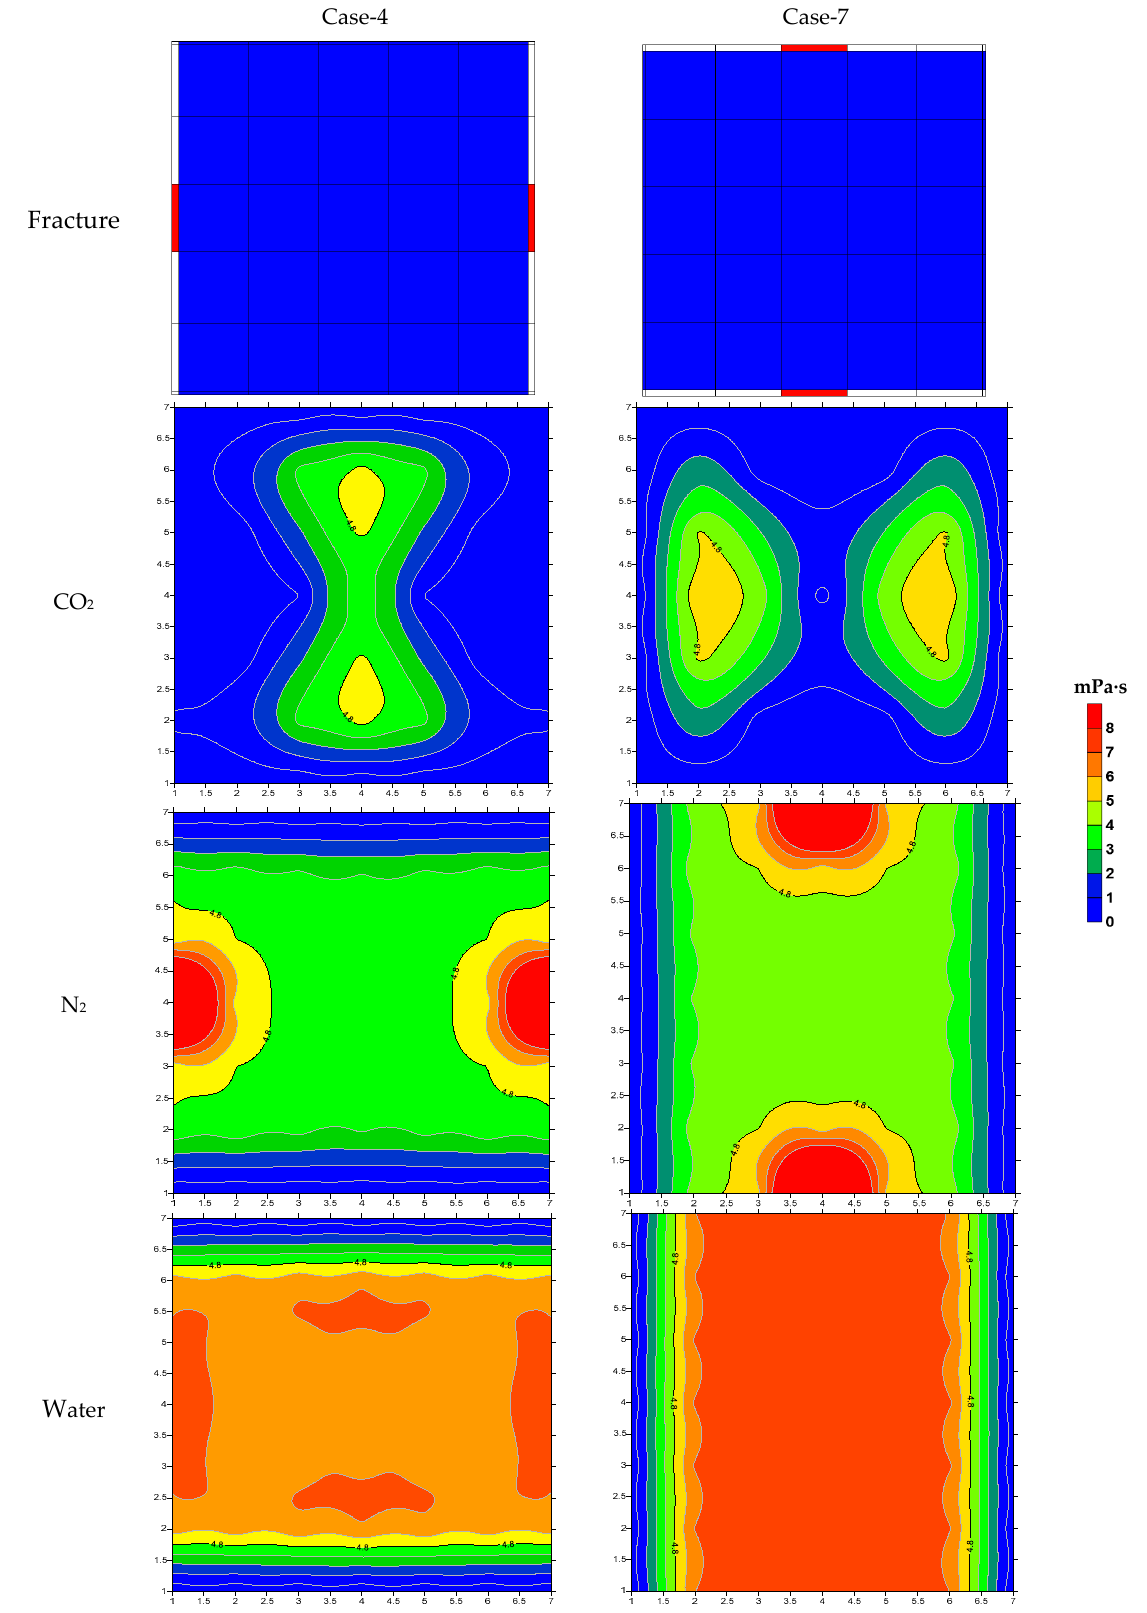
Figure 30. Oil viscosity of different fluids in soaking process ( jk profile).